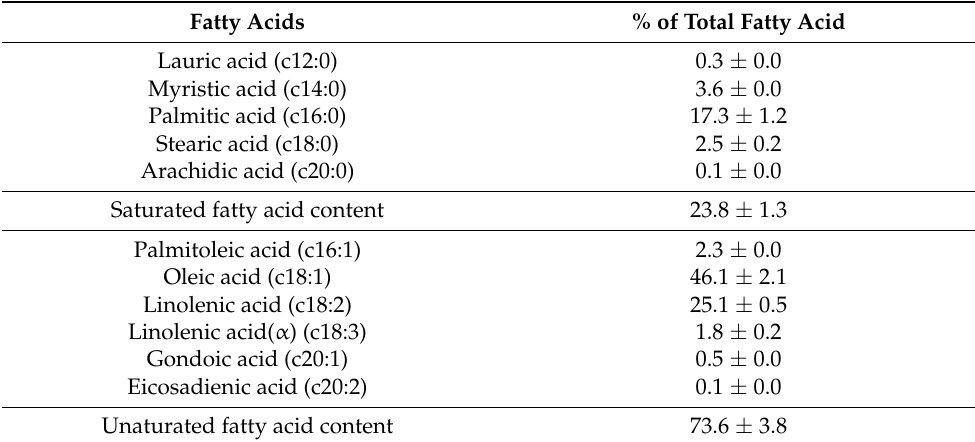
Table 1. Fatty acid composition of Tenebrio molitor